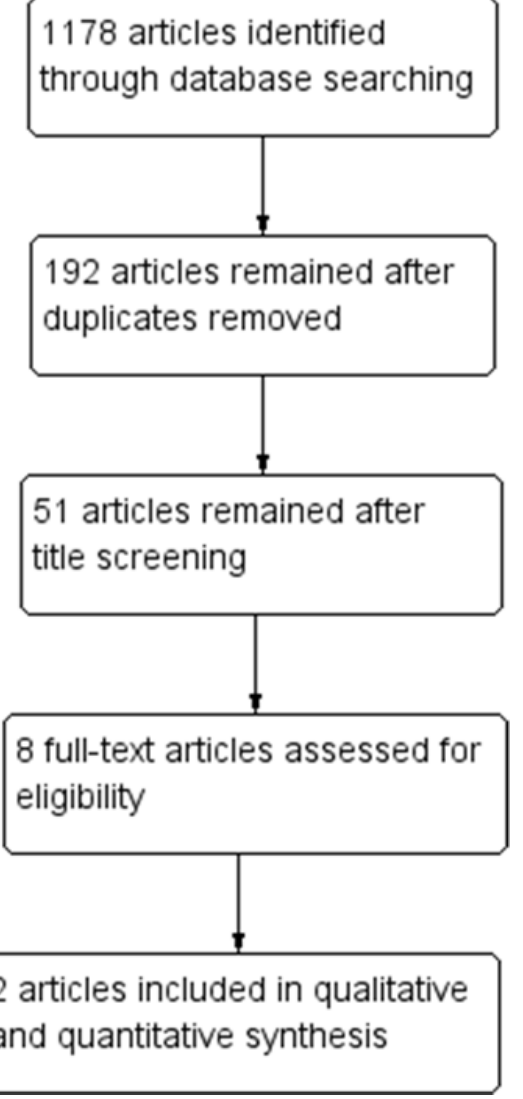
Figure 1. Flow diagram in the systematic review of the identified studies (PRISMA template (preferred reporting items for systematic reviews and meta-analyses)).